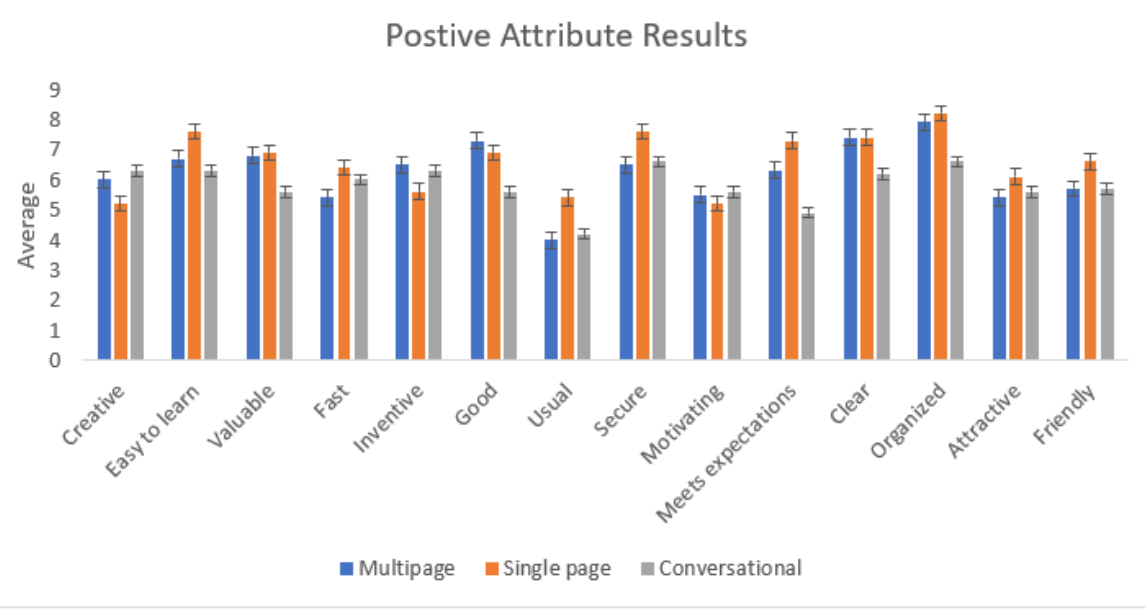
Figure 7. Bar chart showing positive attribute results of the User Experience Questionnaire for all three forms. The single-page form has higher averages for the positive attributes than those of the other two digital forms.